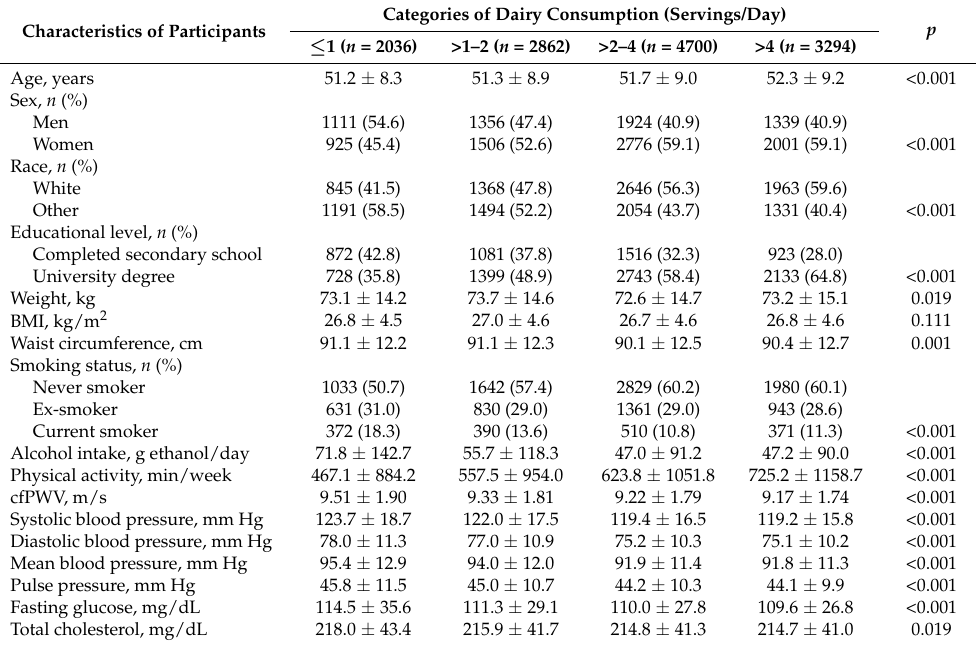
Table 2. Baseline characteristics by categories of dairy consumption of Brazilian participants: ELSA-Brasil, 2008–2010 1